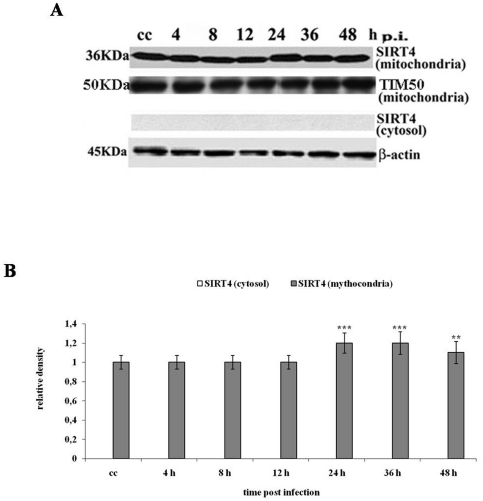
CCoV-II infection modulates SIRT4 protein expression in mitochondrial fraction.(A) Cell lysates were collected at the indicated times p.i., and equal amounts of proteins from each sample were subjected to Western blot analysis and probed for SIRT4. TIM50 was used as a loading control. The molecular weight (KDa) of protein size standards is shown on the left hand side. Blot is representative of three separate experiments. (B) Densitometric analysis of blots relative to SIRT4. The bars represent the mean ± SEM of the results from three separate experiments. Significant differences between CCoV-II-infected cells and control cells are indicated by probability P. **P <0.01 and ***P <0.001.